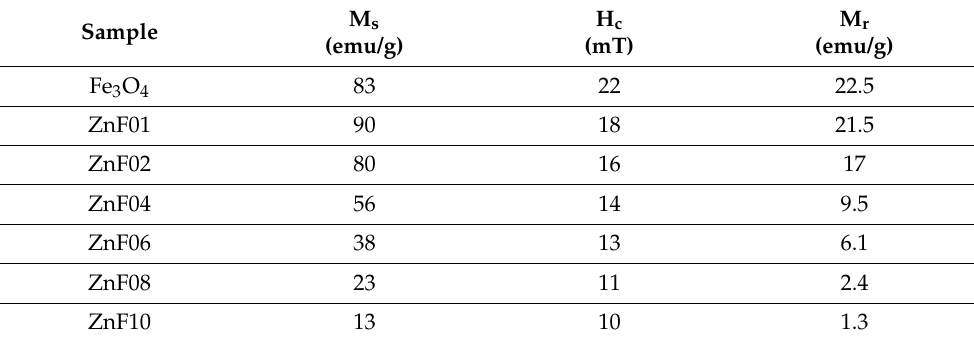
Figure 4. ( a ) Hysteresis loops of Fe 3 O 4 and ZnF particles at 300 K; ( b ) Low-field regime hysteresis loops. Table 2. Magnetic hysteresis parameters of Fe 3 O 4 and ZnF particles at room temperature.